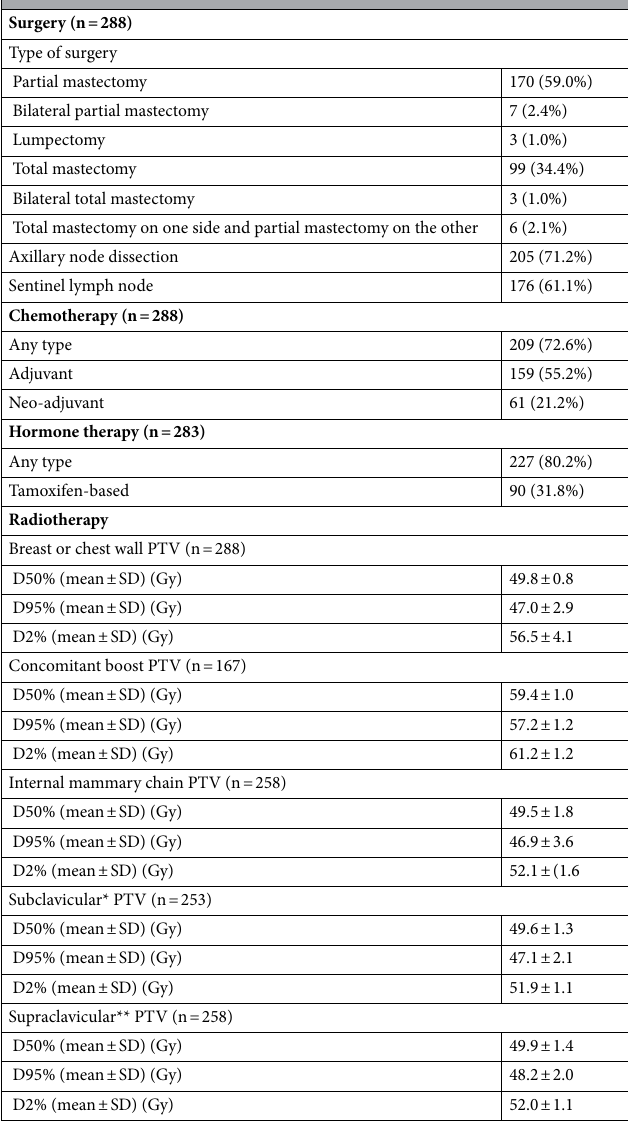
Table 3. Characteristics of the treatments. Data are quoted as the n (%) or the mean ± standard deviation (SD). PTV planning target volume, Dx% dose received by at least x% of the volume. *2 and 3 areas, according to ESTRO guidelines. **Area 4, according to ESTRO